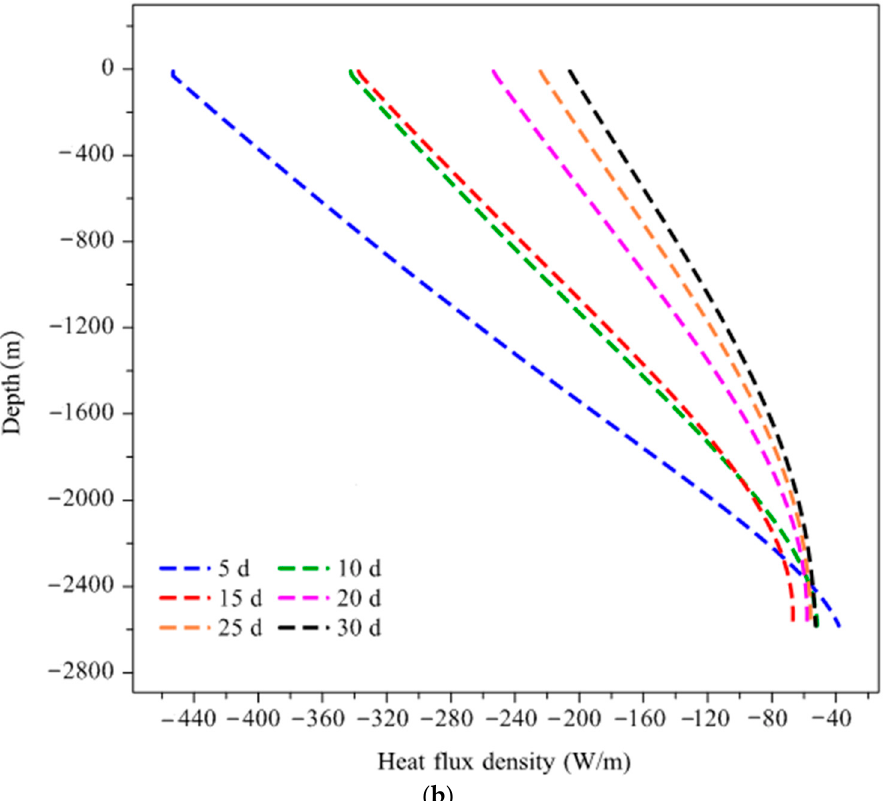
Figure 14. Simulation results for the 30 days high temperature heat storage of deep BTES system: ( a ). Circulating flow temperature profile along depth of borehole; ( b ). Heat flux density distribution along depth of borehole.